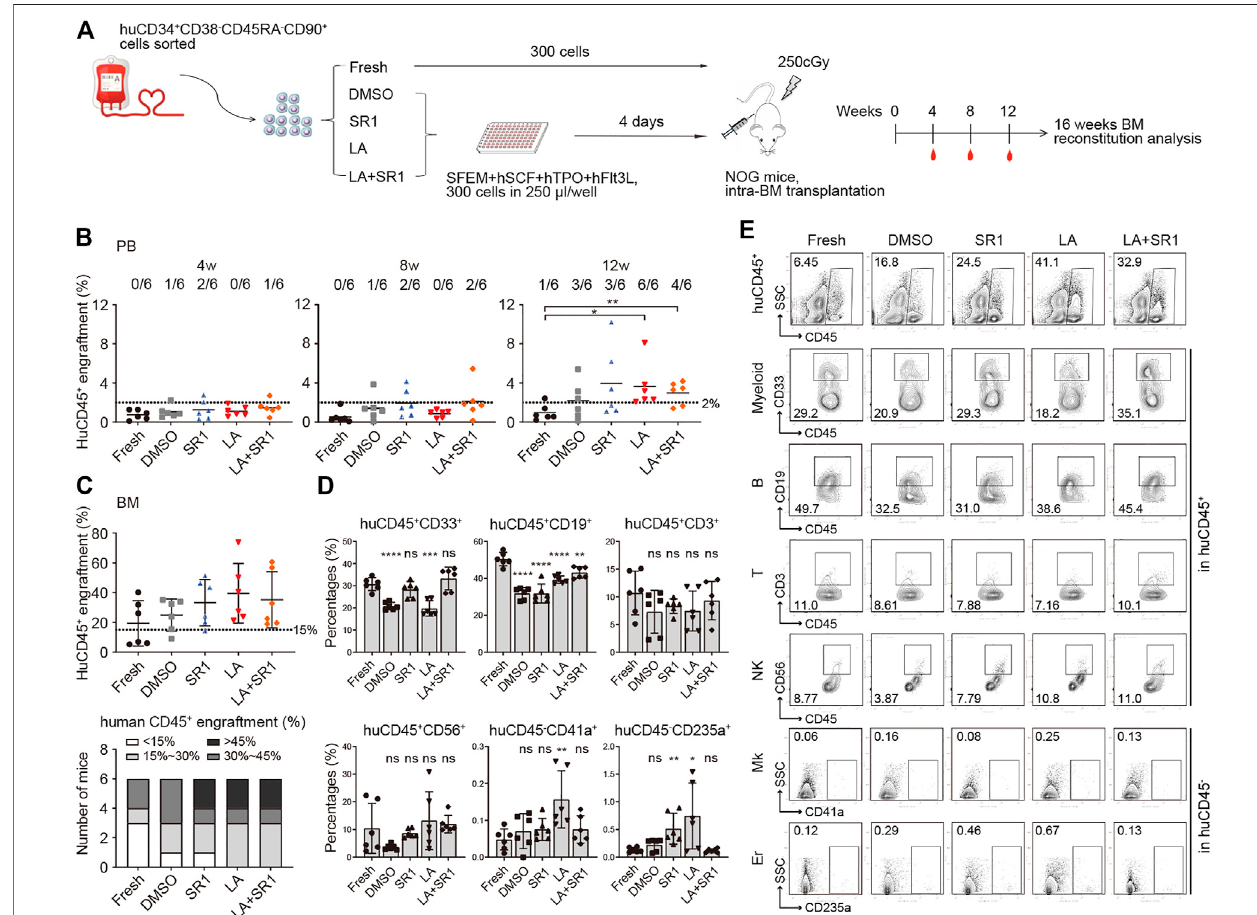
FIGURE 4 | Engraftment and reconstruction of human UCB CD34 + CD38 − CD45RA − CD90 + cells before (fresh) and after a 4-d culture with DMSO, SR1, LA alone, or in combination with SR1 (LA + SR1) in sublethal irradiated NOG mice. (A) Schematic representation of xenograft experiment. NOG mice were transplanted with 300 fresh or cultured cells ( n = 6 mice per group). (B) Human engraftment in peripheral blood (PB) of NOG mice was detected at 4-, 8-, and 12-weeks post-transplantation andmiceweresacri fi cedat16-weekspost-transplantationforbonemarrow(BM)analysis. (B) ThepercentageofhumanCD45 + cellsinPBofNOGmice.Numbers ofmicewith ≥ 2%engraftmentpercentage arespeci fi ed. (C) Thepercentage ofhumanCD45 + cellsinBM ofNOGmice(upperpanel) and thenumberofmiceat different engraftment levels ( < 15%; 15% – 30%; 30% – 45%; > 45%) (lower panel) in each group at 16-weeks post-transplantation. (D) Levels of myeloid (CD45 + CD33 + ), B lymphocytes (CD45 + CD19 + ), T lymphocytes (CD45 + CD3 + ), natural killer cells (CD45 + CD56 + ), megakaryocytes (CD45 − CD41a + ), and erythroid (CD45 − CD235a + ) reconstitution in BM of NOG mice at 16-weeks post-transplantation. (E) Representative FACS pro fi les showing engraftment of human CD45 + cells and multilineage reconstruction described in (C,D) .